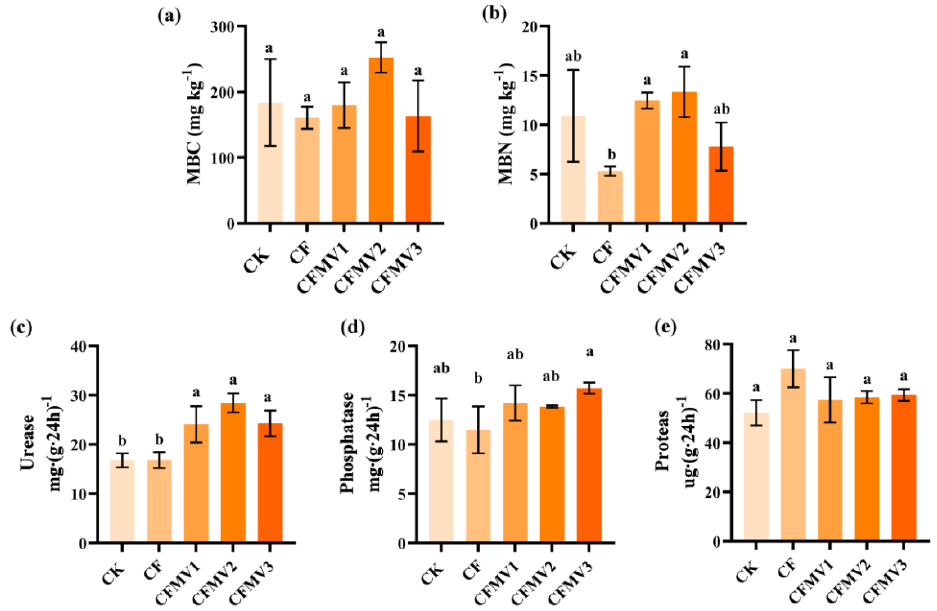
Figure 1. Soil nutrient content and enzyme activity at the rice harvesting stage. ( a ) microbial biomass carbon (MBC) content; ( b ) microbial biomass nitrogen (MBN) content; ( c ) Urease activity; ( d ) Phosphatase activity; ( e ) Proteas activity. Different letters within a column indicate significant differences at p < 0.05. CK, no chemical fertilizers and no CMV; CF, chemical fertilizers; CFMV1, chemical fertilizers + 11,250 kg ha −1 CMV; CFMV2, chemical fertilizers + 22,500 kg ha −1 CMV; and CFMV3, chemical fertilizers + 45,000 kg ha −1 CMV.